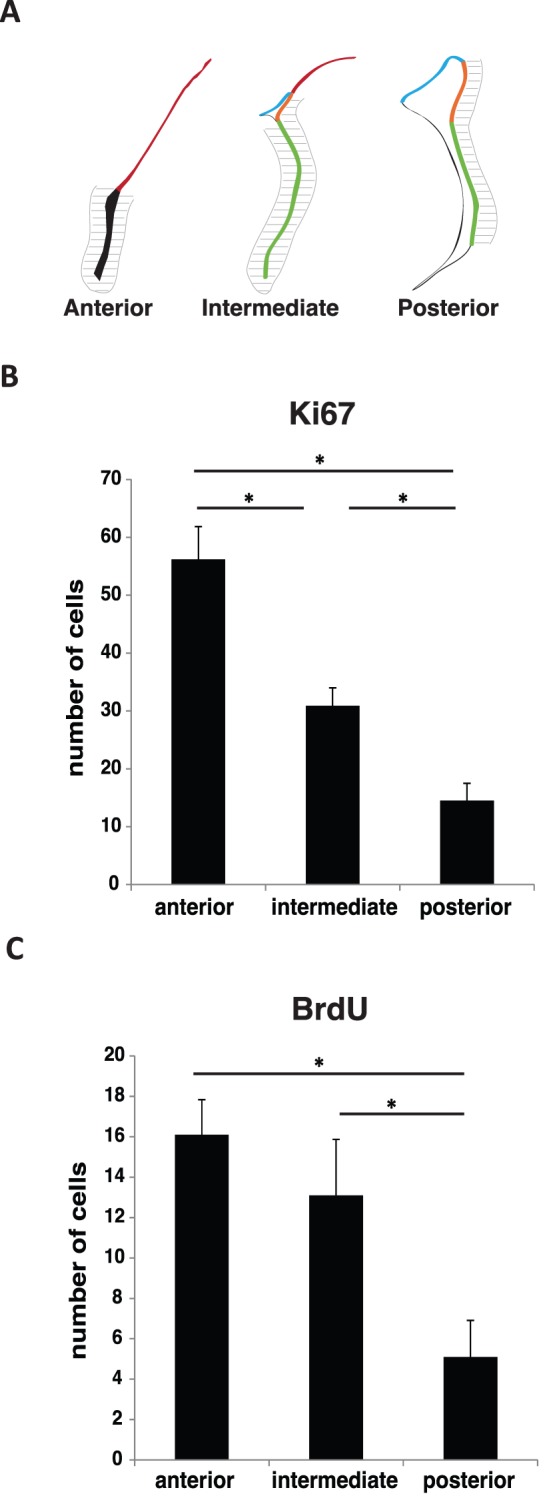
The number of cells proliferating in the vicinity of the subependymal zone decrease along the anterior-posterior axis.(A) An area within a distance of 100 µm apart from the SEZ was defined in the anterior, intermediate and posterior divisions. Ki67 (B) and BrdU (C) positive cells located in the area surrounding the SEZ, as illustrated in (A), were counted. Results are represented as number of Ki67 or BrdU positive cells per section. The threshold value for statistical significance was set at 0.05 (* p<0.05).